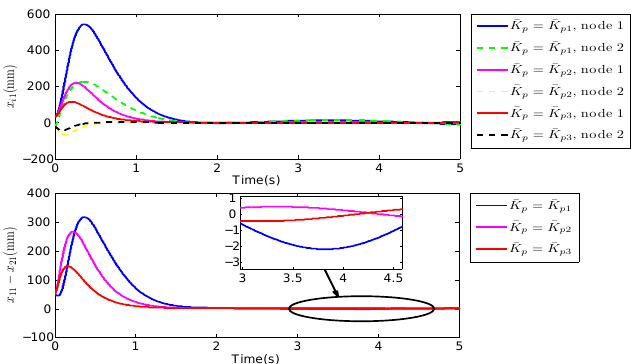
Figure 6. The comparative position response results of the three state-feedback matrixes using pole placement in the simulation.